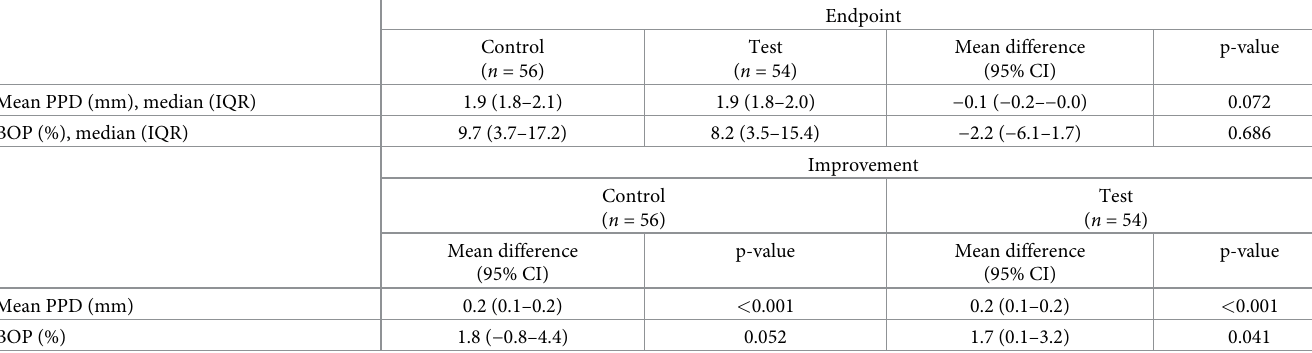
Table 3. Periodontal status at 3 months after the start of the intervention.